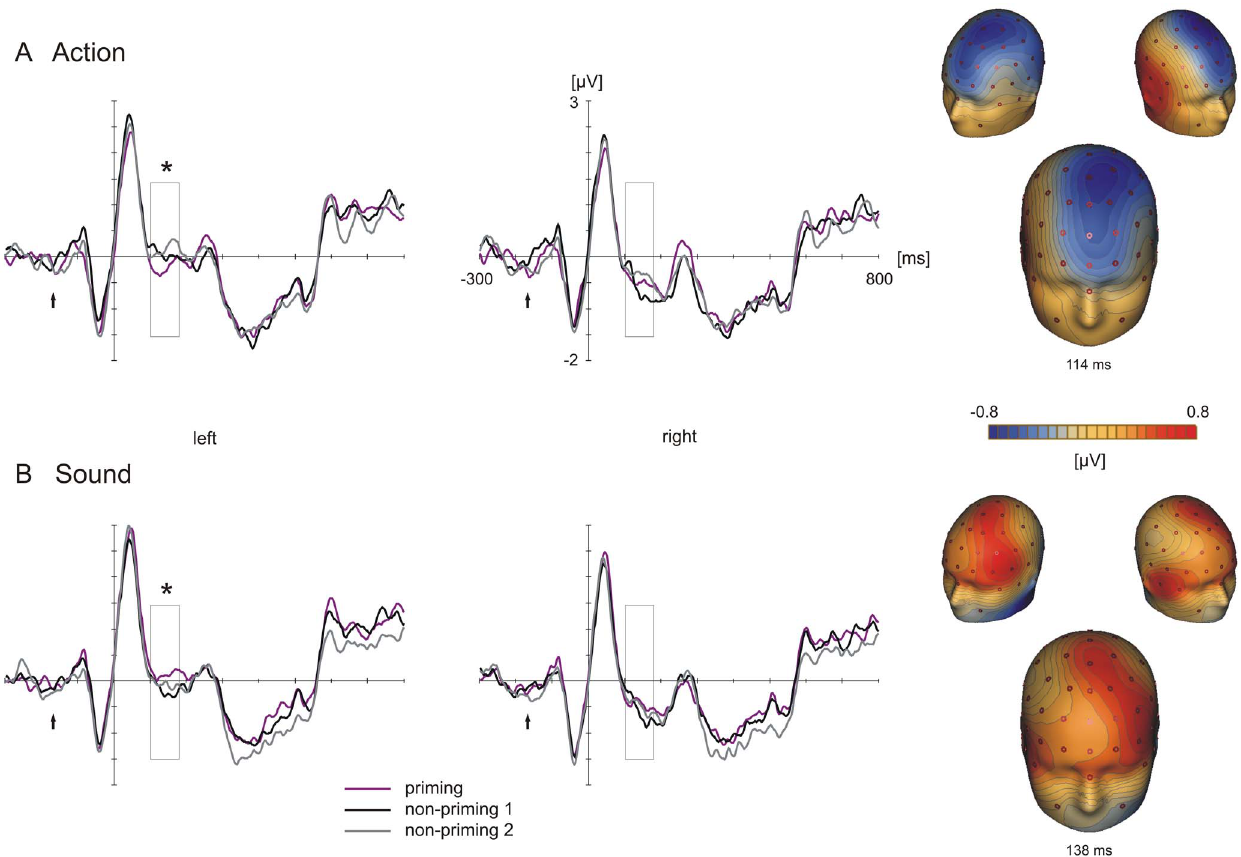
Figure 3. Grand-average ERPs from the fronto-central scalp region of interest as a function of feature type and prime modality (feature-priming vs. non-priming 1 vs. non-priming 2). Shown are the average ERP waveforms elicited by action-related (A) and sound-related (B) words as well as topographic maps of the corresponding action and sound priming effects (difference wave of feature-priming vs. non-priming 1) recorded at its maximum global field power. Black rectangles highlight the critical time window (100-180 ms). Significant priming effects are indicated with a black asterisk and little black arrows denote the onset of the forward mask followed by the prime word and the backward mask. The y-axes indicates the onset of the target word. (100-180 ms) over the fronto-central scalp (for the rationale of time window and electrode site selection, see the methods section).